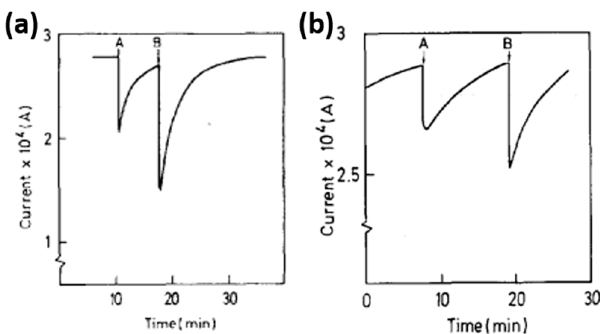
Figure 11. Response of SnO 2 towards vapors of acetone and trichloroethylene ( a ); trichloroethylene and acetone ( b ) under UV excitation. The short-wavelength cut-off of the excitation spectrum is at approximately 200 nm ( a ) and 230 nm ( b ). Reproduced with permission from [49].